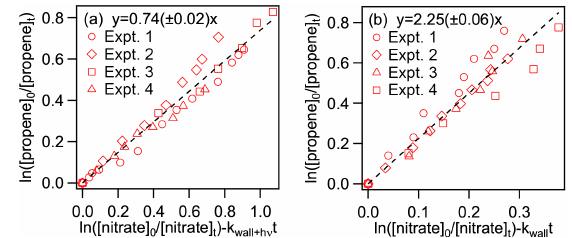
Figure 8. The first-order loss of propene relative to that of the ni- trooxy enal for OH-initiated (a) and O 3 -initiated (b) oxidation re-